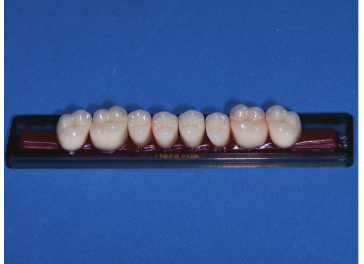
Figure 3: Premium artificial